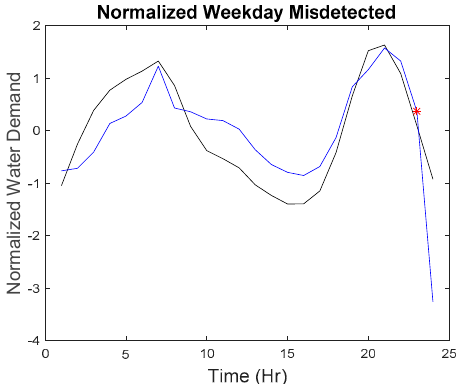
Figure 19. Shape of series with third missed detected anomaly.